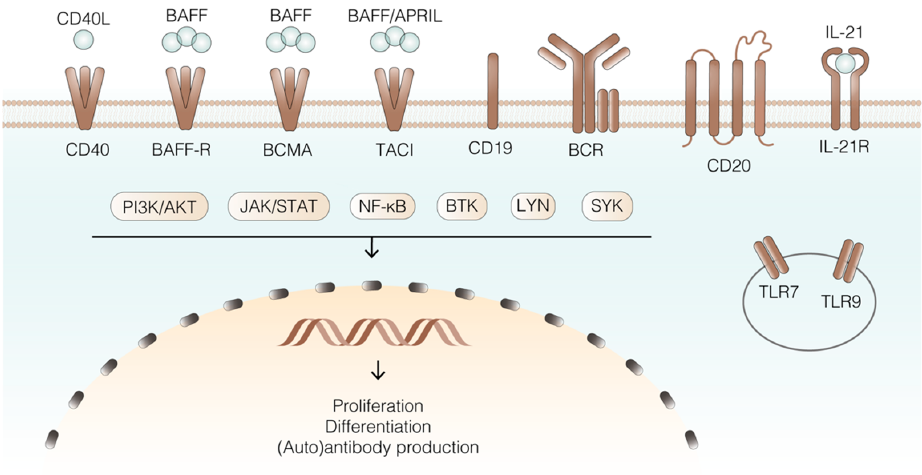
Figure 2. Selection of key receptors, ligands, signalling molecules, and transcriptional regulators of B lineage cells in AAV. B cells present many different receptors on their surface, each triggering specific signalling pathways that eventually lead to transcription of genes necessary for B cell specific and essential functions. Blue: ligands; brown: receptors; cream: effector molecules/signalling pathways. The circle represents the endosome, and the yellow semicircle the nucleus. Abbreviations: BAFF (B cell activating factor), APRIL (a proliferation-inducing ligand), BAFF-R (B cell activating factor receptor), BCMA (B cell maturation antigen), TACI (transmembrane activator and cyclophilin ligand interactor), BCR (B cell receptor), TLR (toll-like receptor), BTK (Bruton’s tyrosine kinase), SYK (spleen tyrosine kinase), NF- κ B (nuclear factor kappa-light-chain-enhancer of activated B cells), JAK (Janus family tyrosine kinases), STAT (signal transducer and activator of transcription), PI3K (phpsphatidylinositol-3-kinase), LYN (Lck/Yes related novel protein tyrosine kinase).